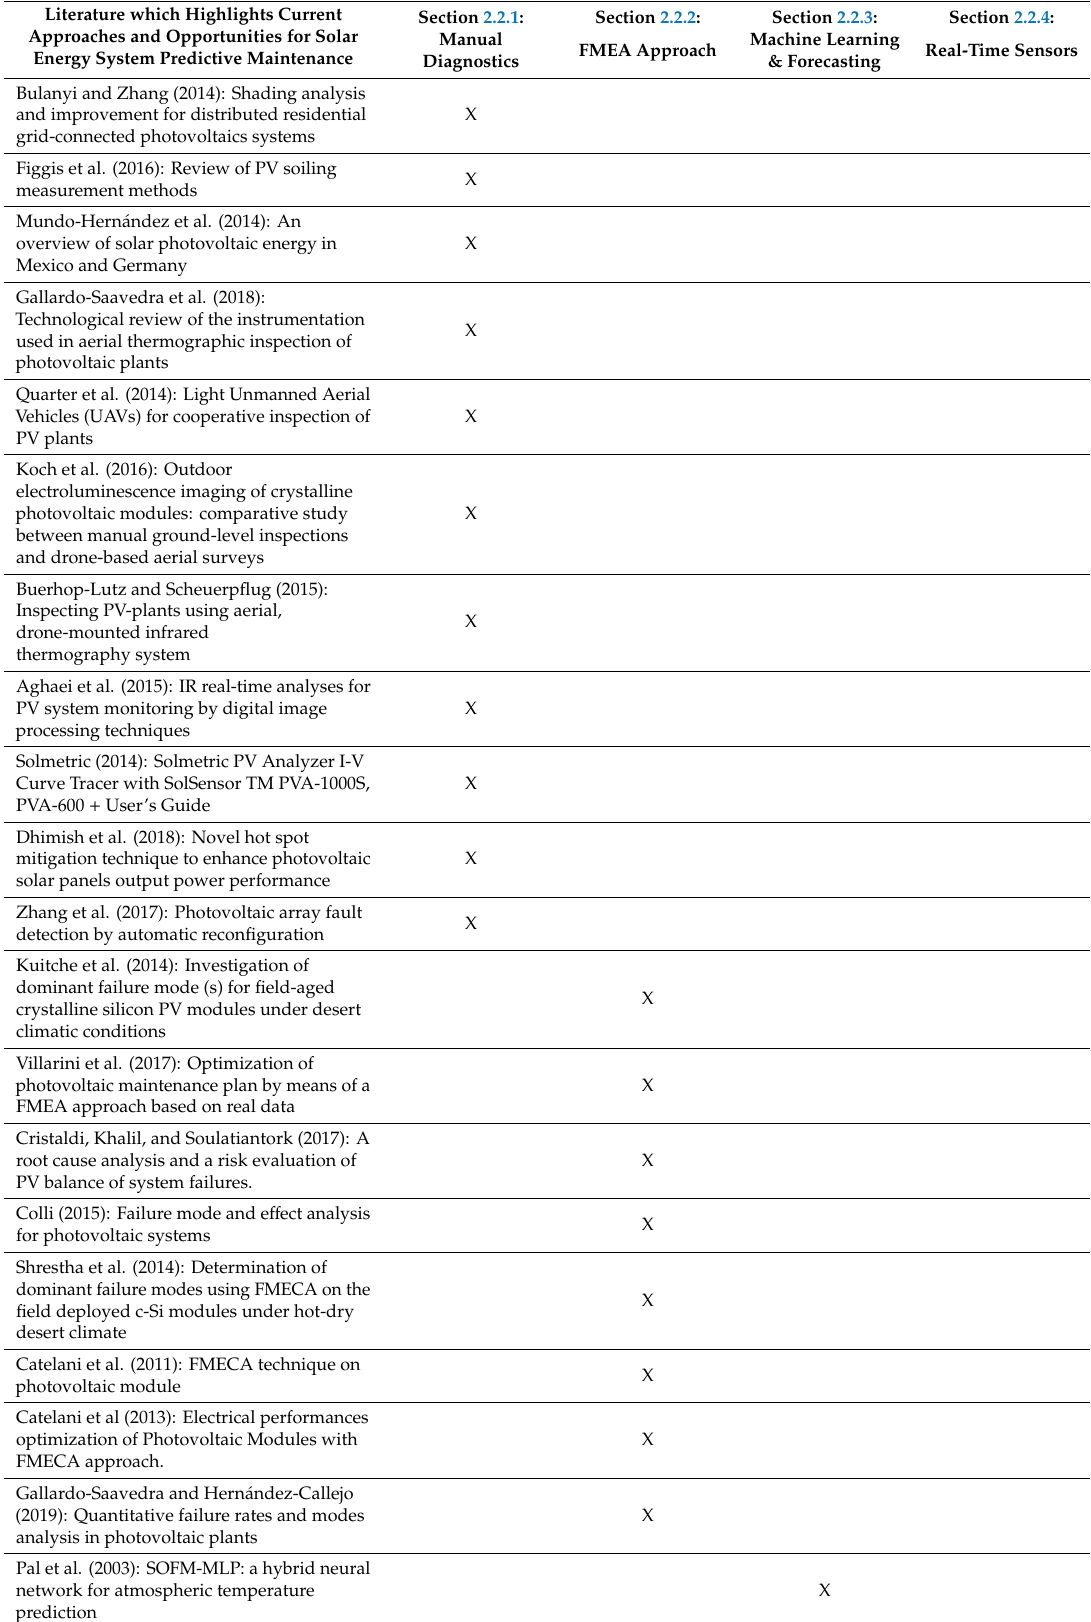
Table 2. Summary of Literature (current approaches and opportunities for predictive